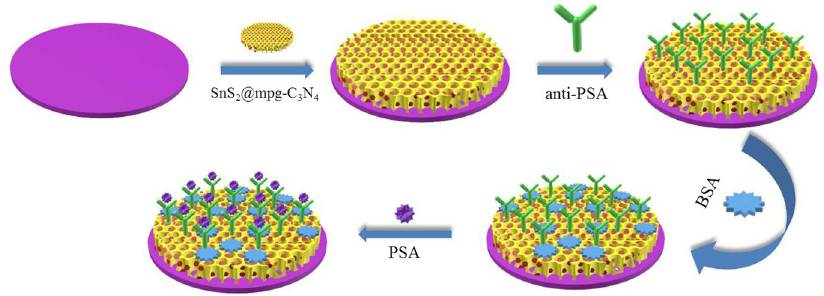
Figure 1. Schematic diagram of the immunosensor construction